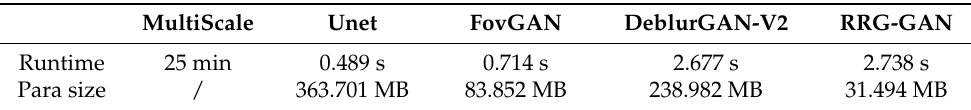
Table 2. Statistics of running time and network parameter size.